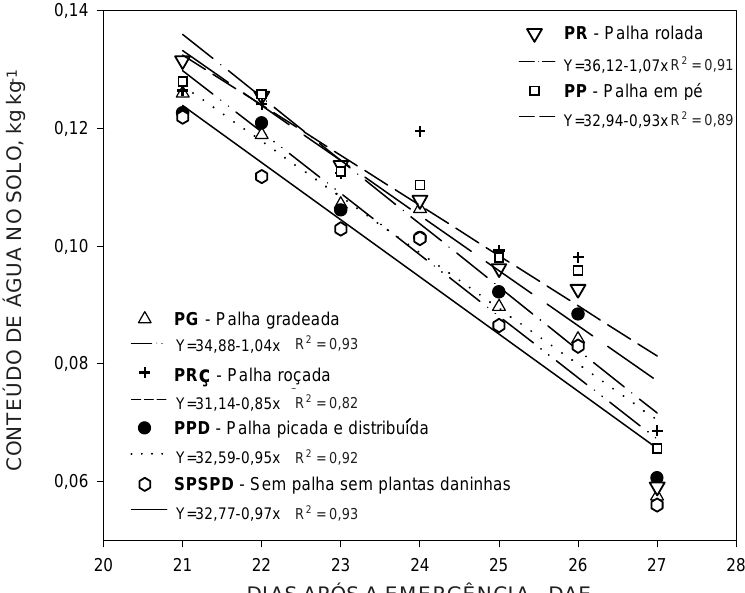
Figura 2. Conteúdo de água no solo à profundidade média de 10 cm, após uma chuva de 12 mm em diferentes manejos da palhada de aveia, considerando o período de avaliação dado em dias após a emergência -